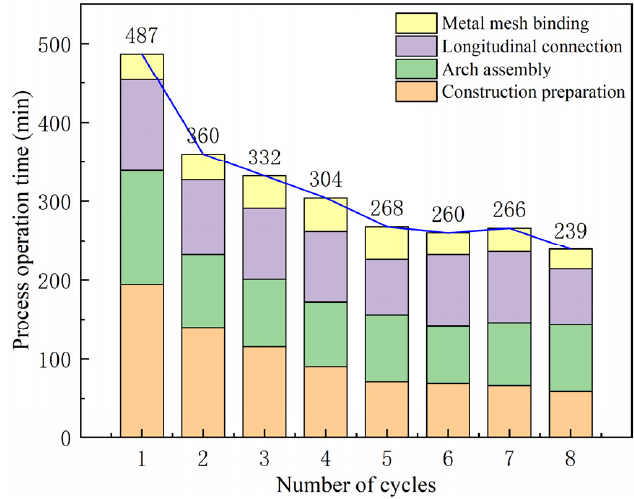
Figure 29. Arch erection operation time with different cycles.